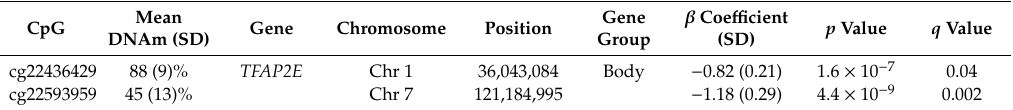
Figure 2. Association between DNAm levels at cg22593959 ( A ) and cg22436429 ( B ) and childhood adiposity. Robust linear regressions were computed in R with gestational age at birth, sex of the offspring, age at follow-up and cell composition estimation as covariates. Results were considered significant based on FDR correction for multiple testing ( q < 0.05). Table 2. Adjusted di ff erence in skinfold thickness in early childhood with a 1% change in placental DNA methylation